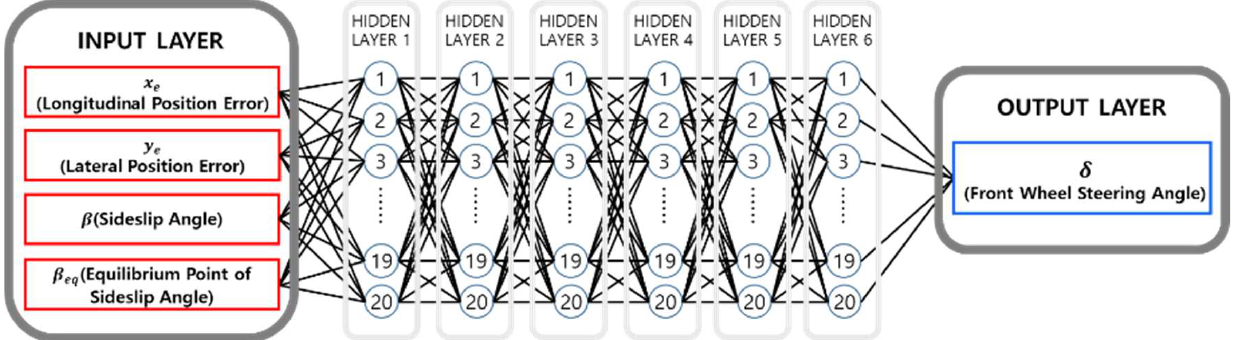
Figure 15. Deep neural network architecture for lateral positioning control.